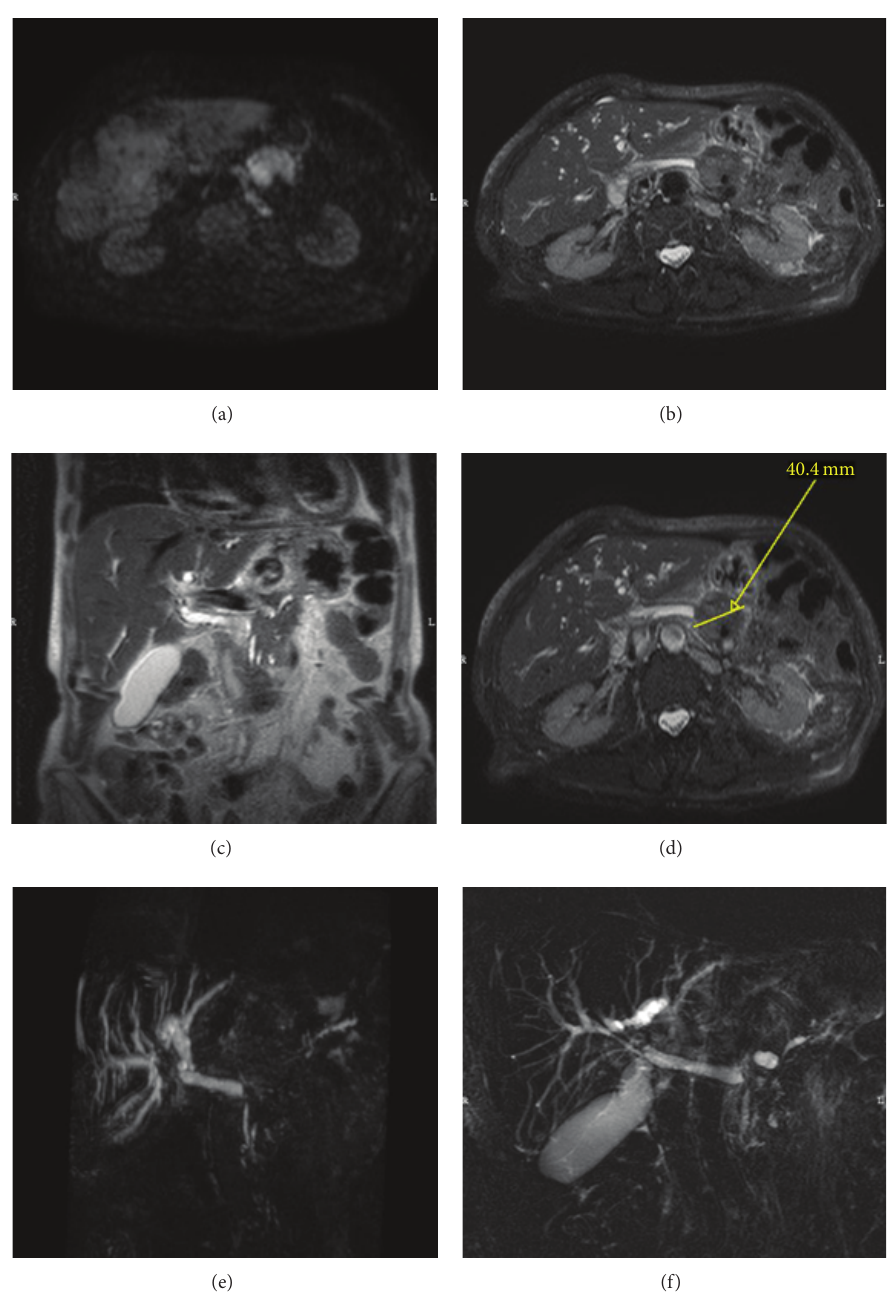
Figure 2: NMR evaluation of pancreatic lesion. (a) Diffusion weighted imaging (DWI) axial sequence shows a hyperintense pancreatic body mass with restricted apparent diffusion coefficient (ADC) value, confirmed in ADC map; (b) single shot axial T2-weighted fat sat image shows pancreatic body mass isointense to liver parenchyma; (c) single shot coronal T2-weighted image shows dilated extrahepatic biliary duct; (d) as shown in (b), with the indication of diameter of the lesion (4 centimeters); (e) 3D maximum intensity projection (MIP) coronal image showing dilated intra- and extrahepatic biliary ducts without evidences of middle segment of Wirsung duct; (f) T2-weighted radial big slab image of the same condition presented in